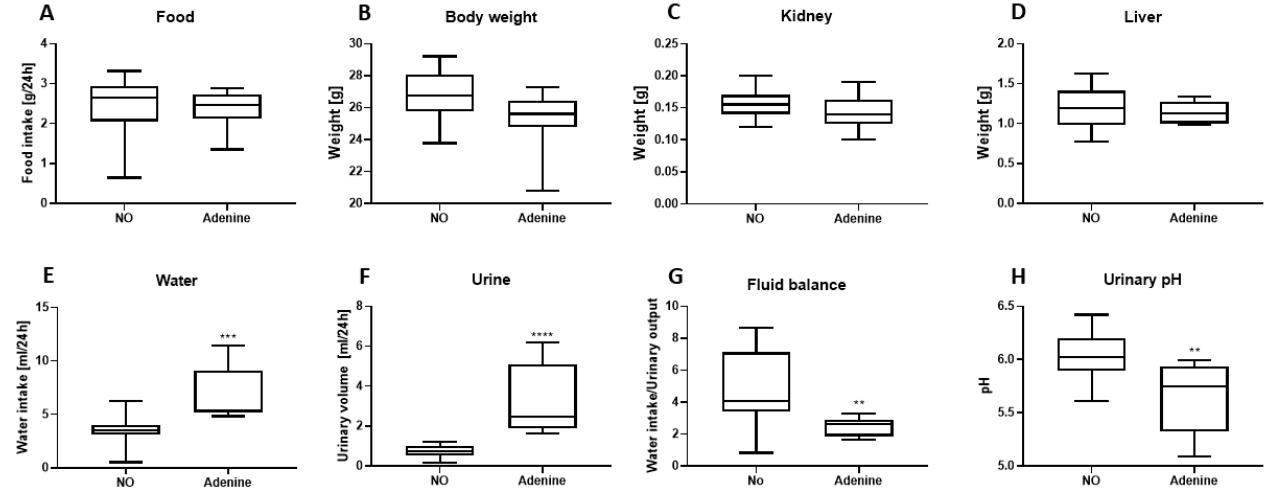
Figure 1. Mice follow-up in metabolic cages and at time of sacrifice. ( A ) Food intake; ( B ) Body weight; ( C ) Kidney weight; ( D ) Liver weight; ( E ) Water intake; ( F ) Urinary excretion; ( G ) Fluid balance calculated as water intake/urine volume, and ( H ) Urinary pH. NO represents the control group, fed with WD-CAC. Data are plotted as median with whiskers indicating Min and Max values ( n = 9–11), with ** p < 0.01, *** p < 0.001 and **** p < 0.0001 for statistical difference. To estimate the impact of adenine on renal function, biochemical parameters were measured in urine and serum (Table 1). In urine, the 24 h net excretion of Na + , Ca 2+ , Mg 2+ , and Pi was significantly increased, whereas creatinine, K + , Cl − , urea, and glu- cose remained unchanged. Creatinine and blood urea nitrogen (BUN) were also con- stant in the serum, whereas osmolality, FGF23, and glucose were markedly increased. The renal function of both groups was then assessed using the Urea Urine /Urea Serum and Creatinine Urine /Creatinine Serum ratios; both ratios were significantly reduced ( p < 0.001) in mice fed with adenine, indicating CKD induction (Table